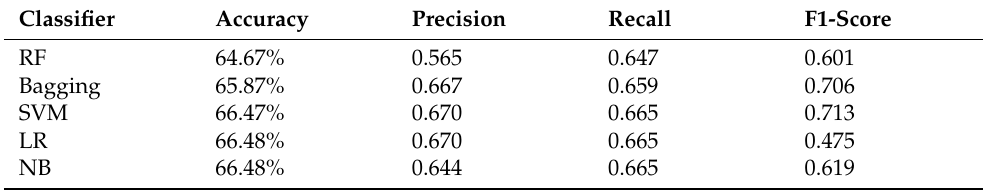
Table 18. Experiments with ML models and the Bing Lui lexicon on the TextBlob sentiments.